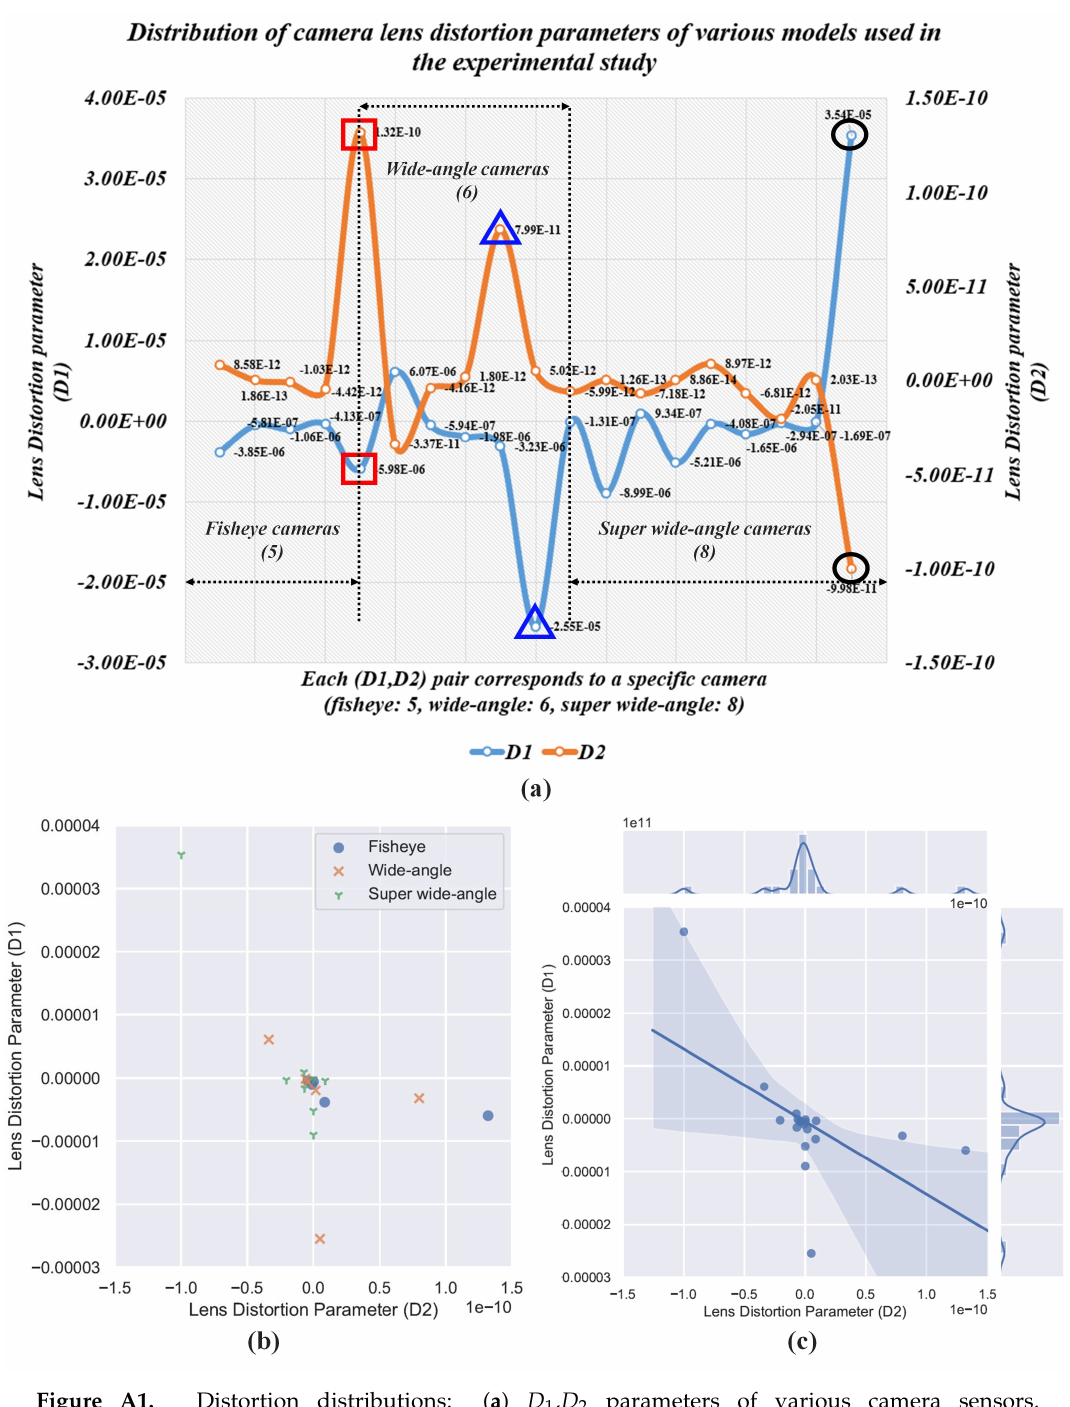
Figure A1. Distortion distributions: ( a ) D 1 , D 2 parameters of various camera sensors. ( b ) D 1 , D 2 distributions w.r.t camera models. ( c ) Regression plot to investigate the common region spread of D 1 and D 2